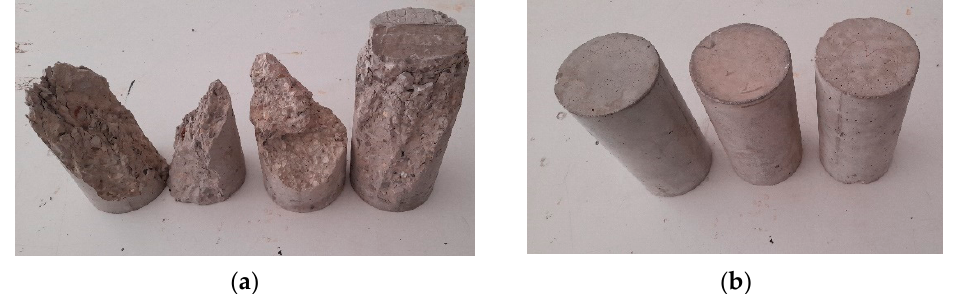
Figure 4. Cylindrical specimens after heating. ( a ) SCC35 specimens, ( b ) OC35 specimens.